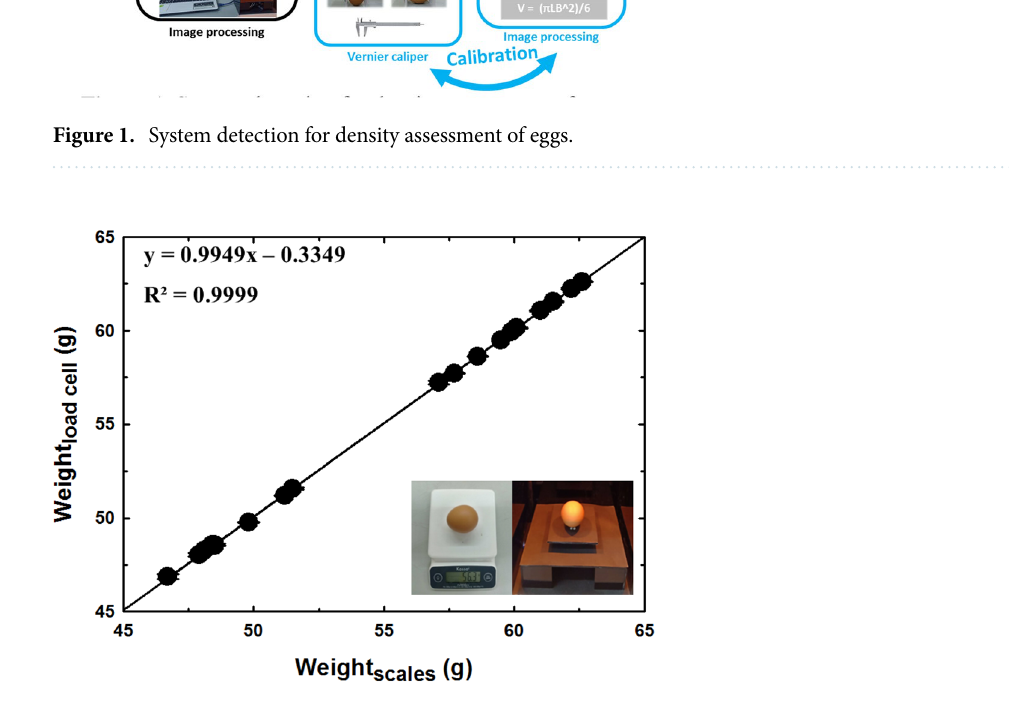
Figure 2. Measurement of weight and